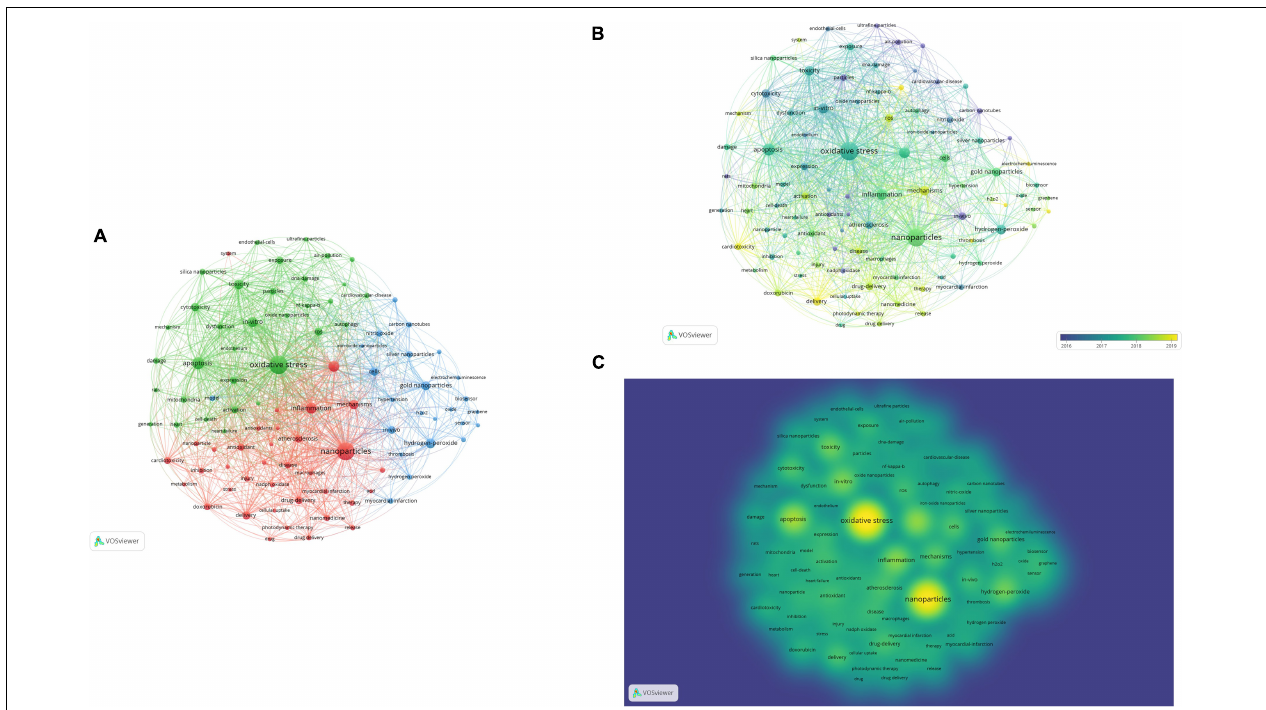
FIGURE 8 | Co-occurrence analysis of all keywords with an occurrence frequency more than 12 (of the 3,922 keywords, 93 meet the threshold). Colors are used to indicate clusters. Circle size is based on the number of occurrence. Settings in VOSviewer Analysis: Method: Lin Log/modularity; Resolution: 1.0; Minimum cluster size: 2; Attractions:1; Repulsion:-1. (A) Network mapping of keywords of related studies (three clusters). (B) Overlay mapping of keywords according to average publication year (blue means earlier, yellow means later). (C) Density mapping of keywords according to the frequency of appearance (yellow means more